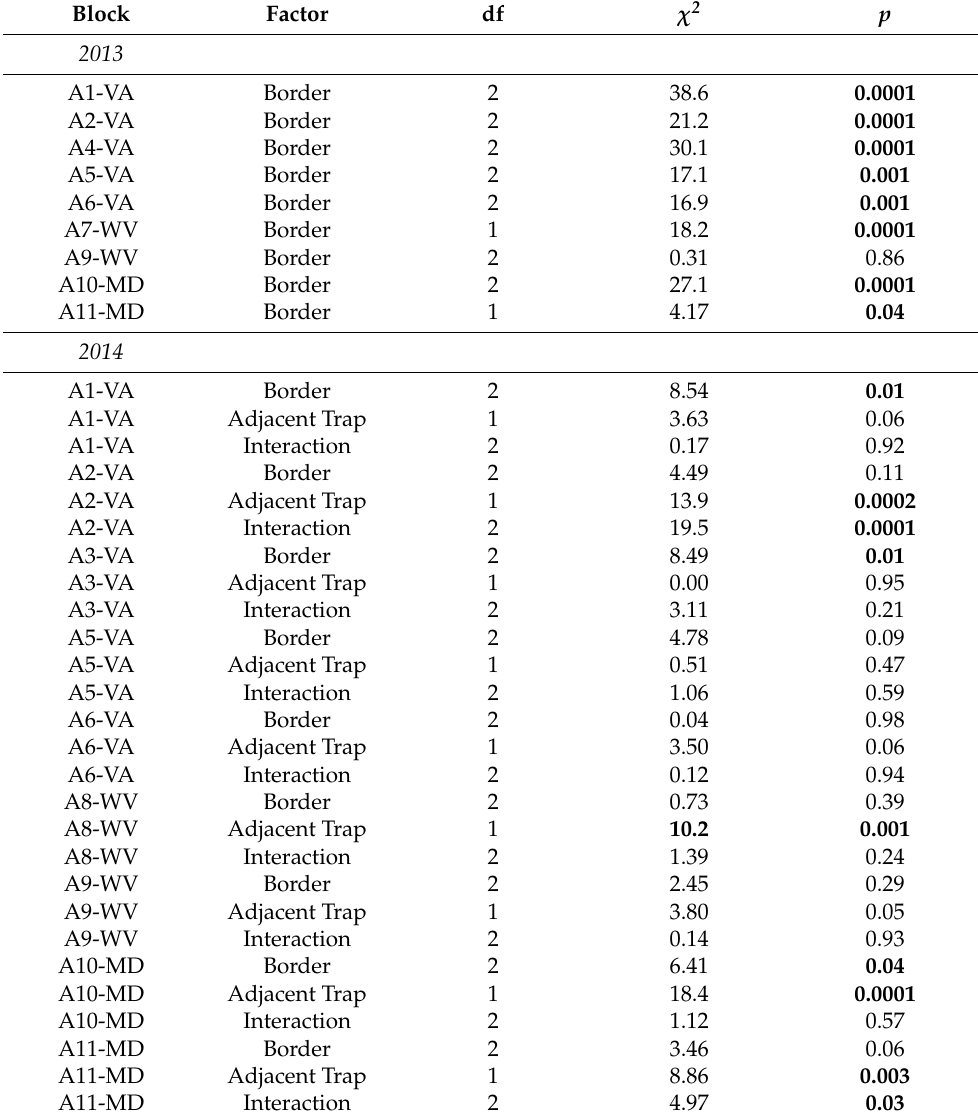
Table 3. Summary of statistical results for the incidence of external fruit injury from H. halys in 9 apple blocks per year (2013 and 2014) in the Mid-Atlantic, USA. Significant p values are highlighted in bold